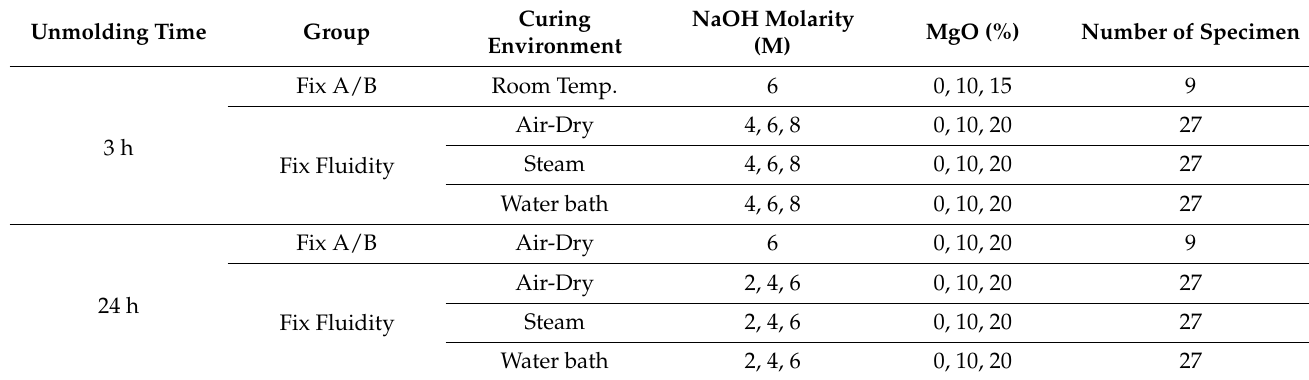
Table 3. The experimental planning of the length change ratio.